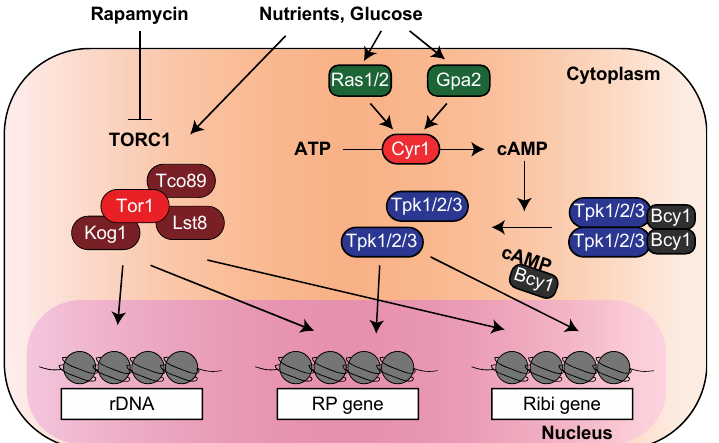
Figure 2. Regulatory mechanism of ribosomal genes by TOR and PKA pathways. Of the two TOR complexes, TORC1, composed of Tor1, Kog1, Lst8, and Tco89, primarily regulates the transcription of ribosomal genes. Nutrient limitation or rapamycin treatments causes the inactivation of TORC1, leading to the downregulation of ribosomal gene expressions. The PKA pathway also contributes to the expression of ribosomal genes. In the presence of glucose, Cyr1, activated by Ras1/2 and Gpa2, converts ATP to cAMP. As a result of cAMP inhibiting Bcy1, free Tpk activates the transcription of ribosomal genes.